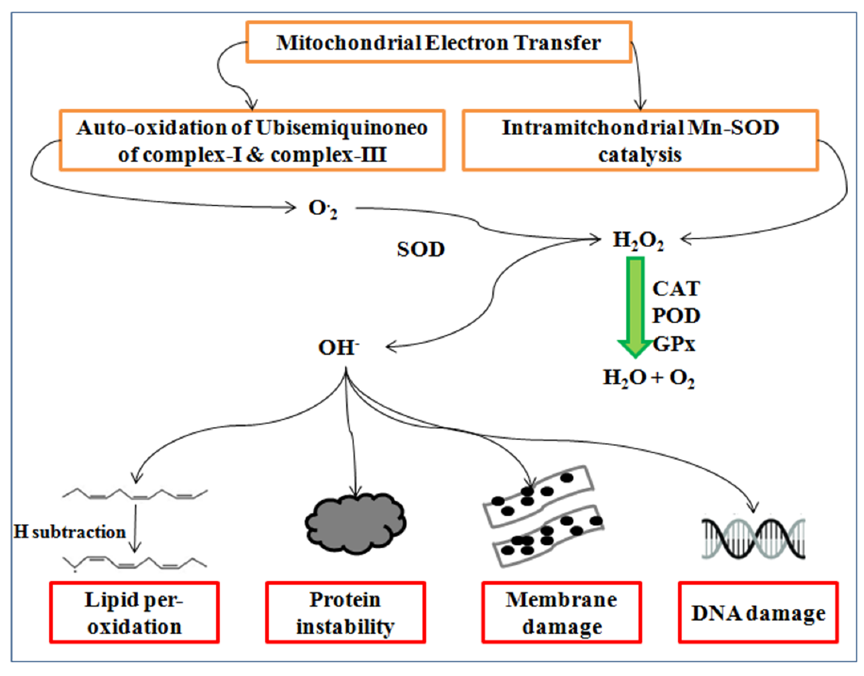
Figure 6. Synthesis of the reactive oxygen species and their consequences.